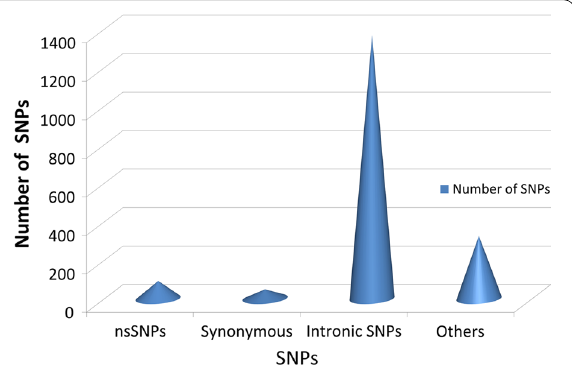
Fig. 1 Clustered pyramid showing the number and distribution of SNPs in IL10 gene based on dbSNP database. (nsSNPs: 91, Synonymous SNPs: 48, Intronic SNPs: 1337, Other SNPs: